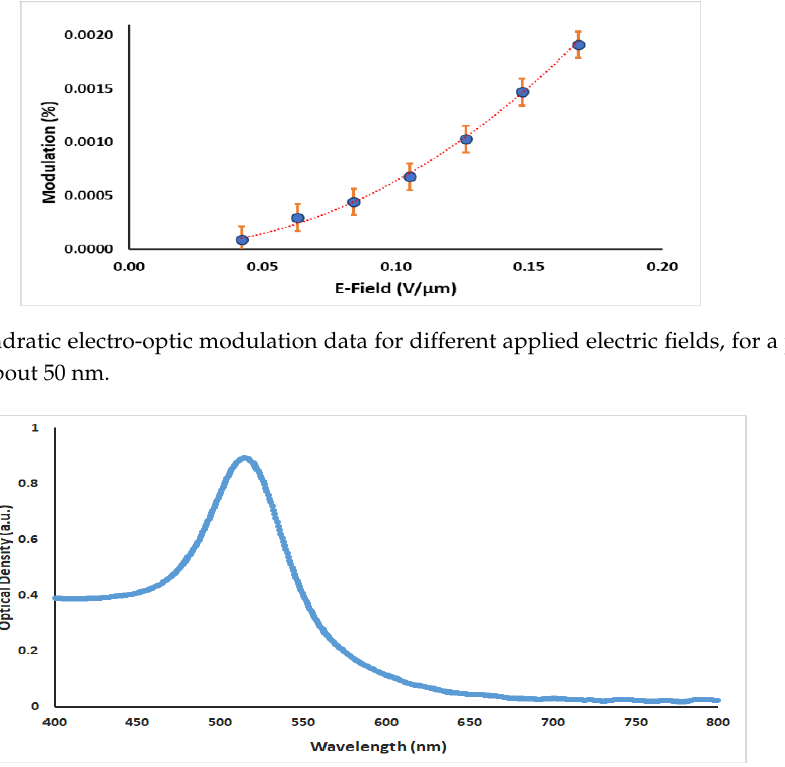
Figure 4. Surface plasmon resonance spectrum of gold nanoparticles in glass (Sample 3, peak at about 520 nm) with a particle diameter of about 15